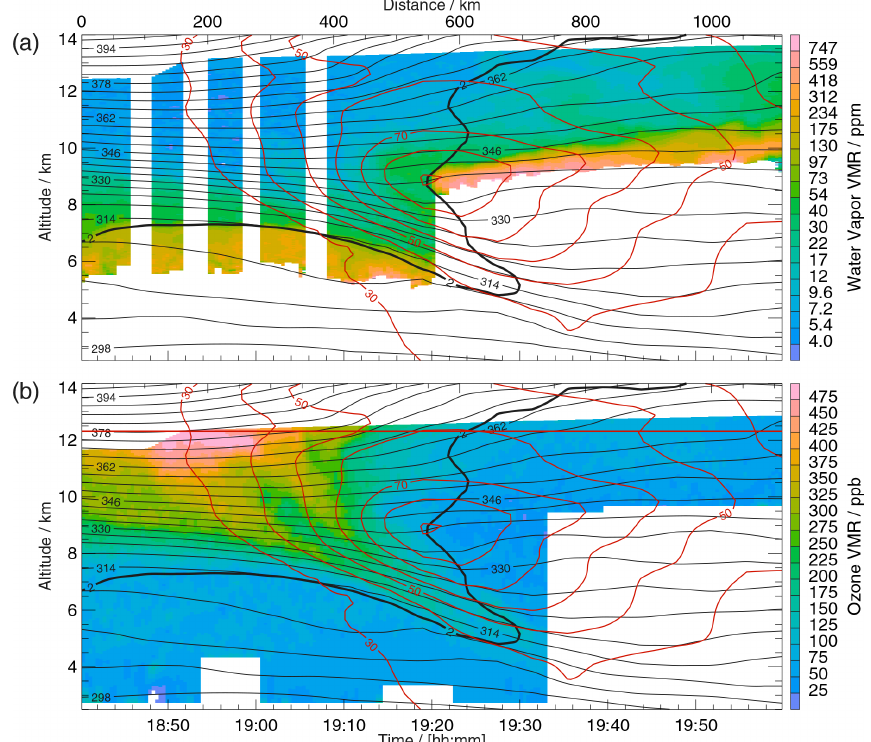
Figure 3. DIAL observations (in colors) of (a) H 2 O volume mixing ratio (VMR; in ppm = 10 − 6 molmol − 1 = µmolmol − 1 ) and (b) O 3 VMR (in ppb = 10 − 9 molmol − 1 = nmolmol − 1 ) on 1 October 2017 (see Fig. 1 for the flight track). Panels (a) and (b) are superimposed by horizontal wind speed (red contours; in ms − 1 for wind speeds > 30ms − 1 ), potential temperature (black contours; in K) and